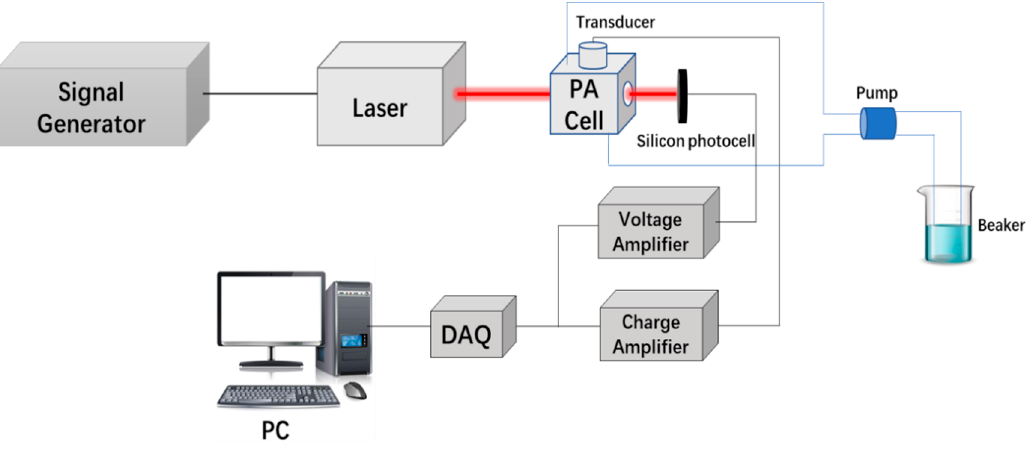
Figure 1. The framework of the photoacoustic (PA) measuring system.